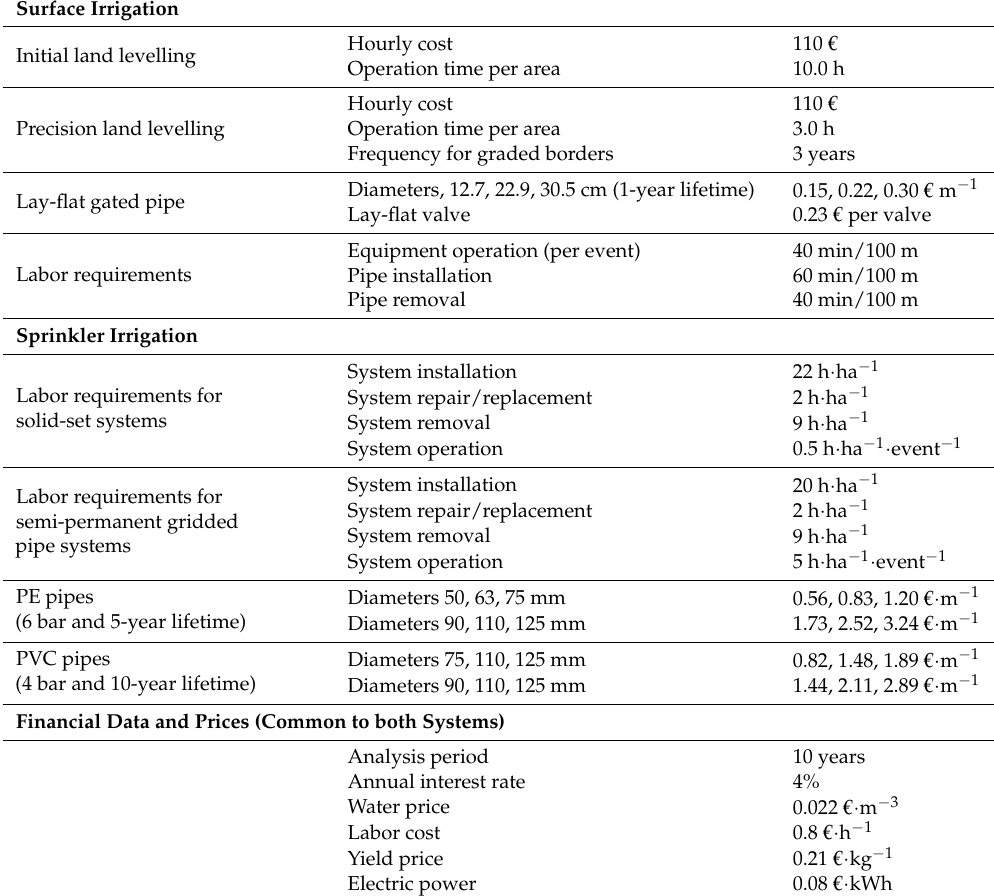
Table 4. Labor requirements and unit costs for surface and sprinkler